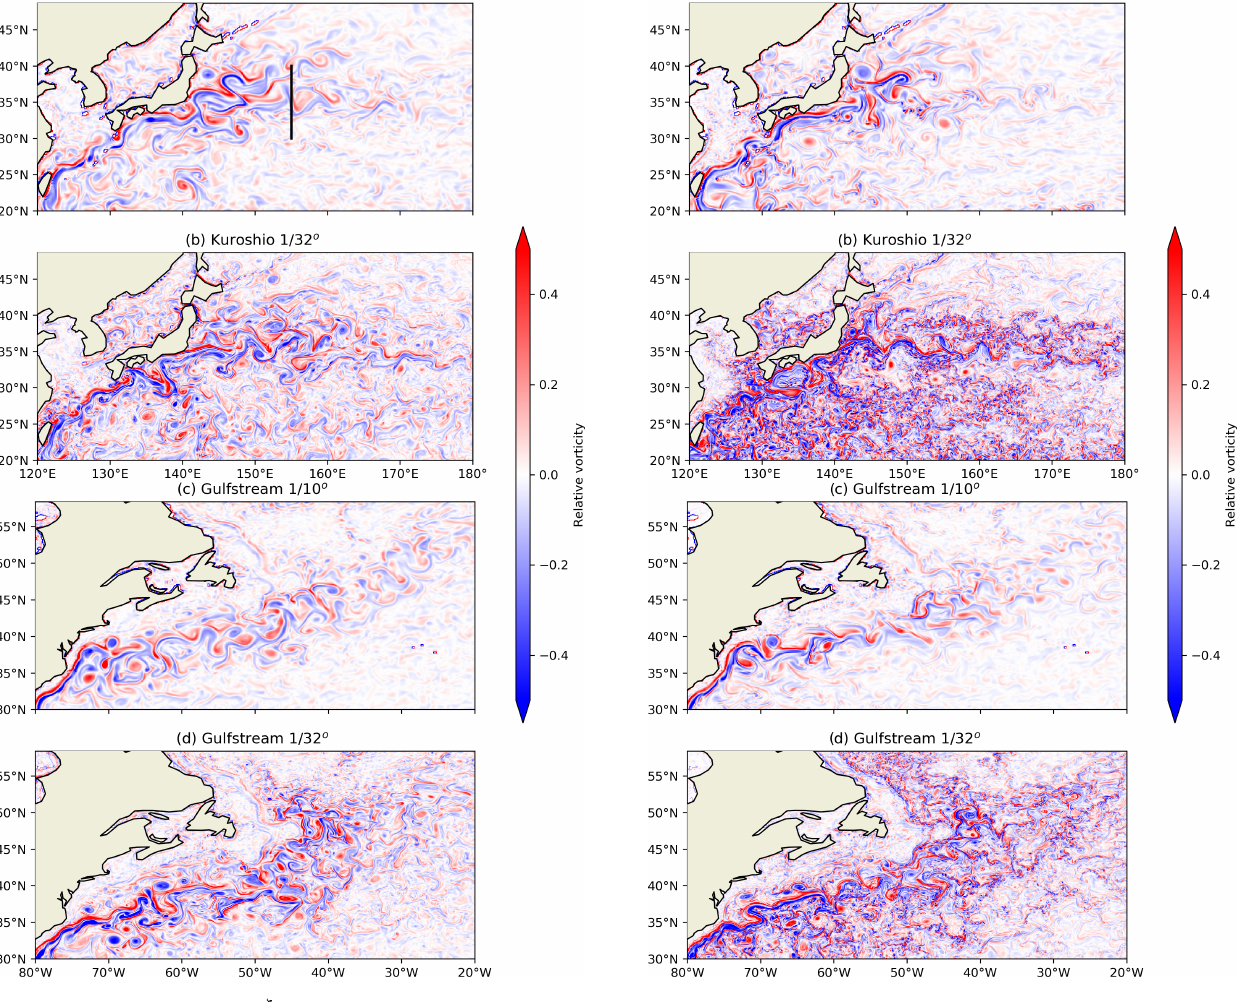
Figure 6. Relative vorticity ( ζ ) of the sea surface current in the f 1 / 10 (a, c) and 1 / 32 ◦ (b, d) model results. Snapshots of summer (1 September 2019) of the Kuroshio region (a, b) and the Gulf Stream region (c, d) .